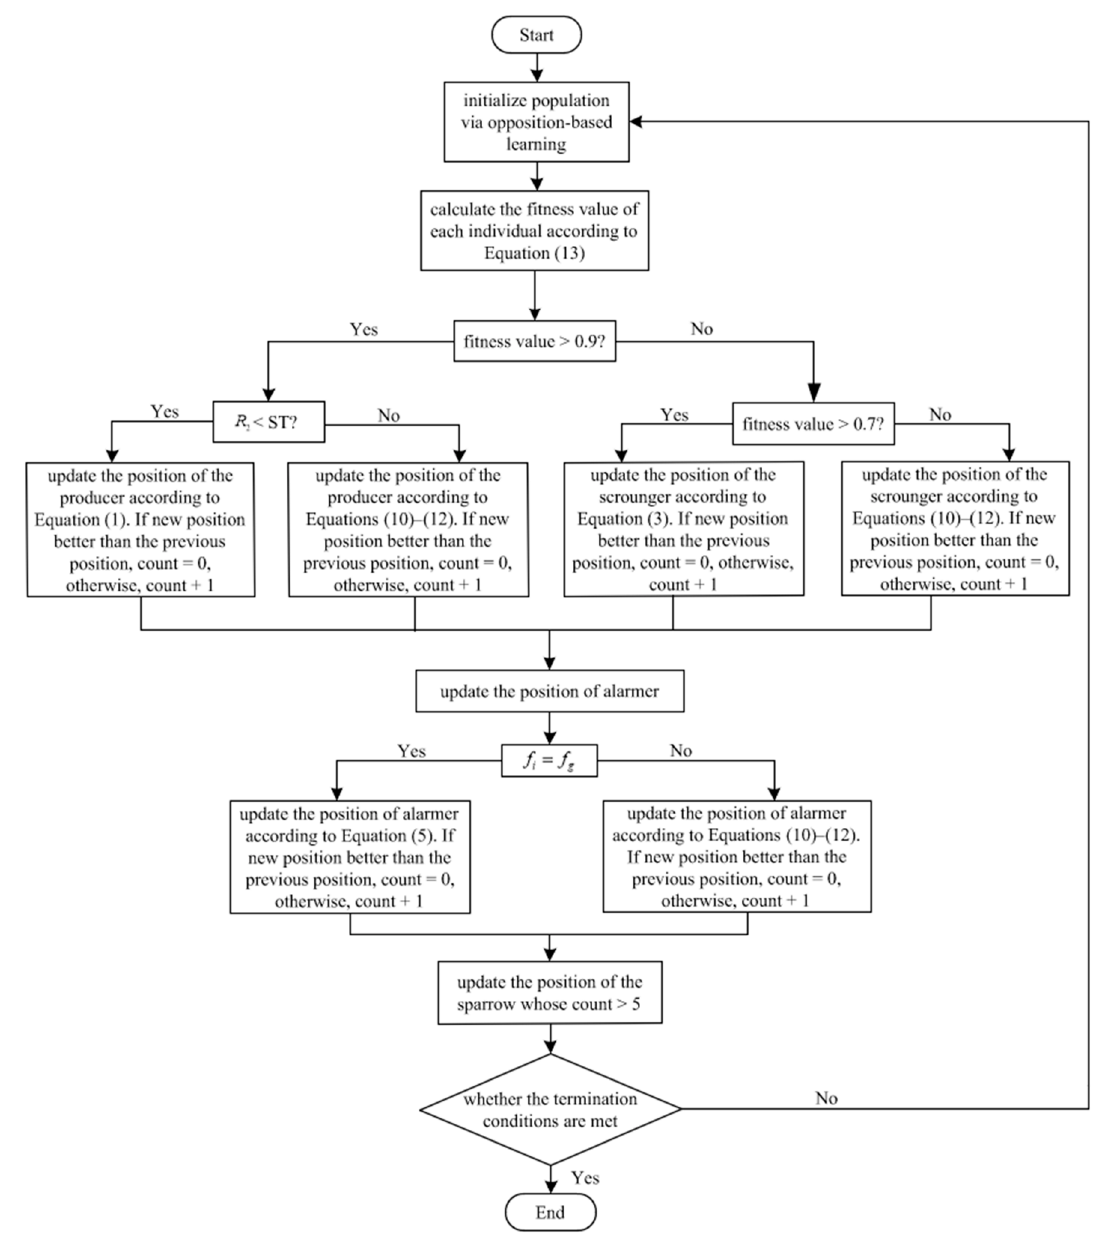
Figure 1. Flowchart of FOSSA. First of all, opposition-based learning is used to generate initial population for improving the quality and diversity of initial population. In addition, the Lévy flight is utilized in Equations (2) and (6). Finally, fitness-based learning is introduced into the whole searching process of sparrows.